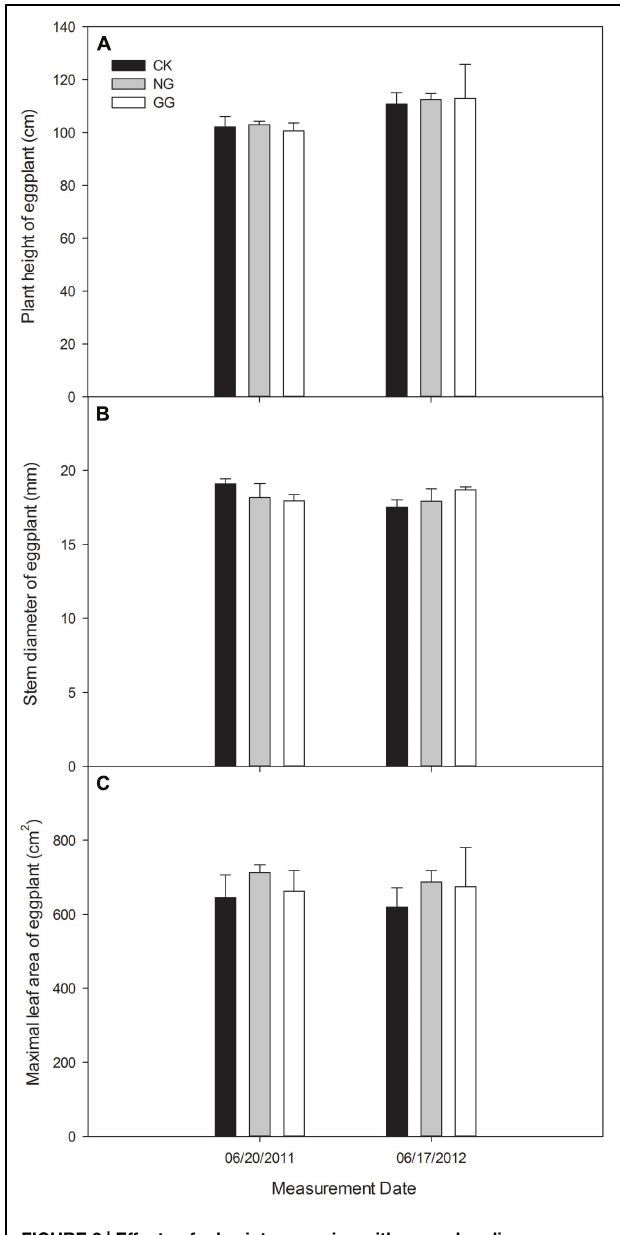
FIGURE 3 | Effects of relay intercropping with normal garlic or green garlic on the plant height (A), stem diameter (B) and maximum leaf area (C) of eggplant. Error bars represent the standard error of the mean, n = 3. CK, eggplant monoculture; NG, eggplant under relay intercropping with normal garlic; GG, eggplant under relay intercropping with green garlic.